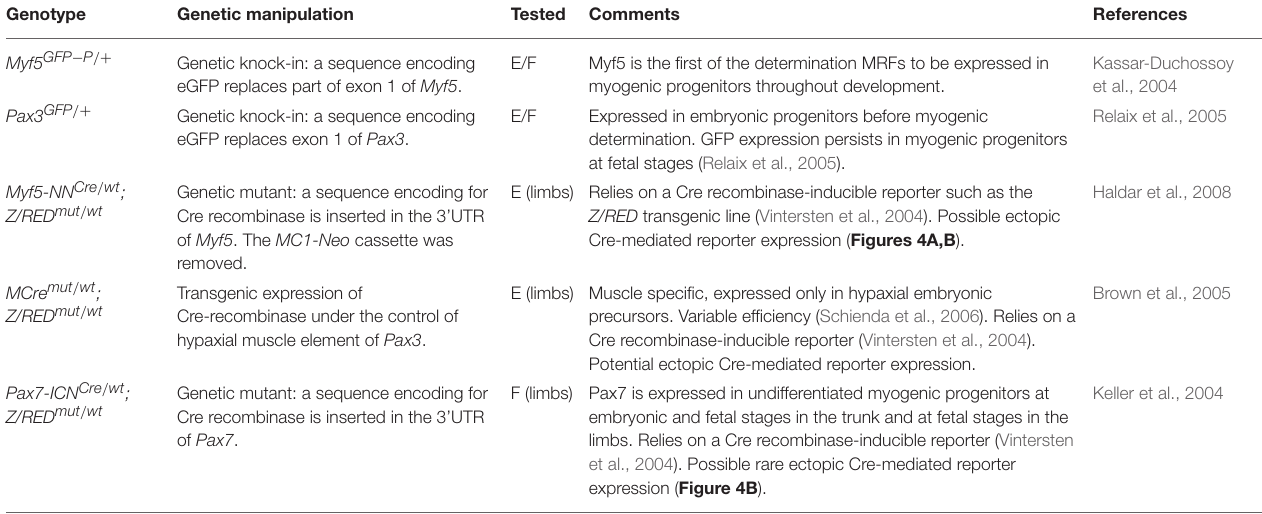
TABLE 1 | Summary of the mouse lines described in this protocol. Genotype Genetic